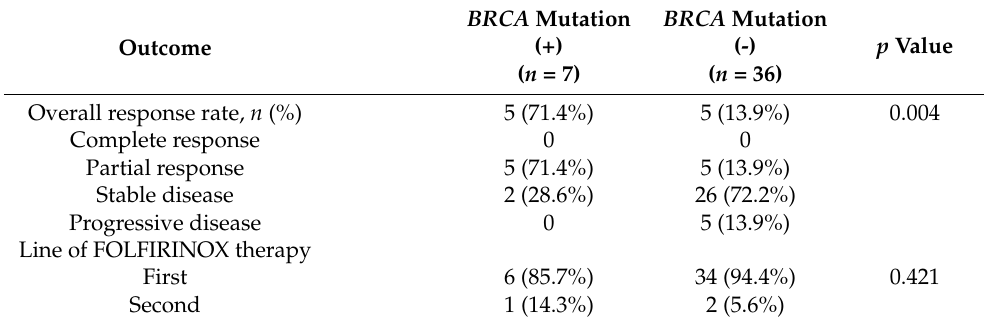
Table 3. Overall response rate to FOLFIRINOX in patients with a germline BRCA 1/2 mutation was significantly higher than patients without the mutation.